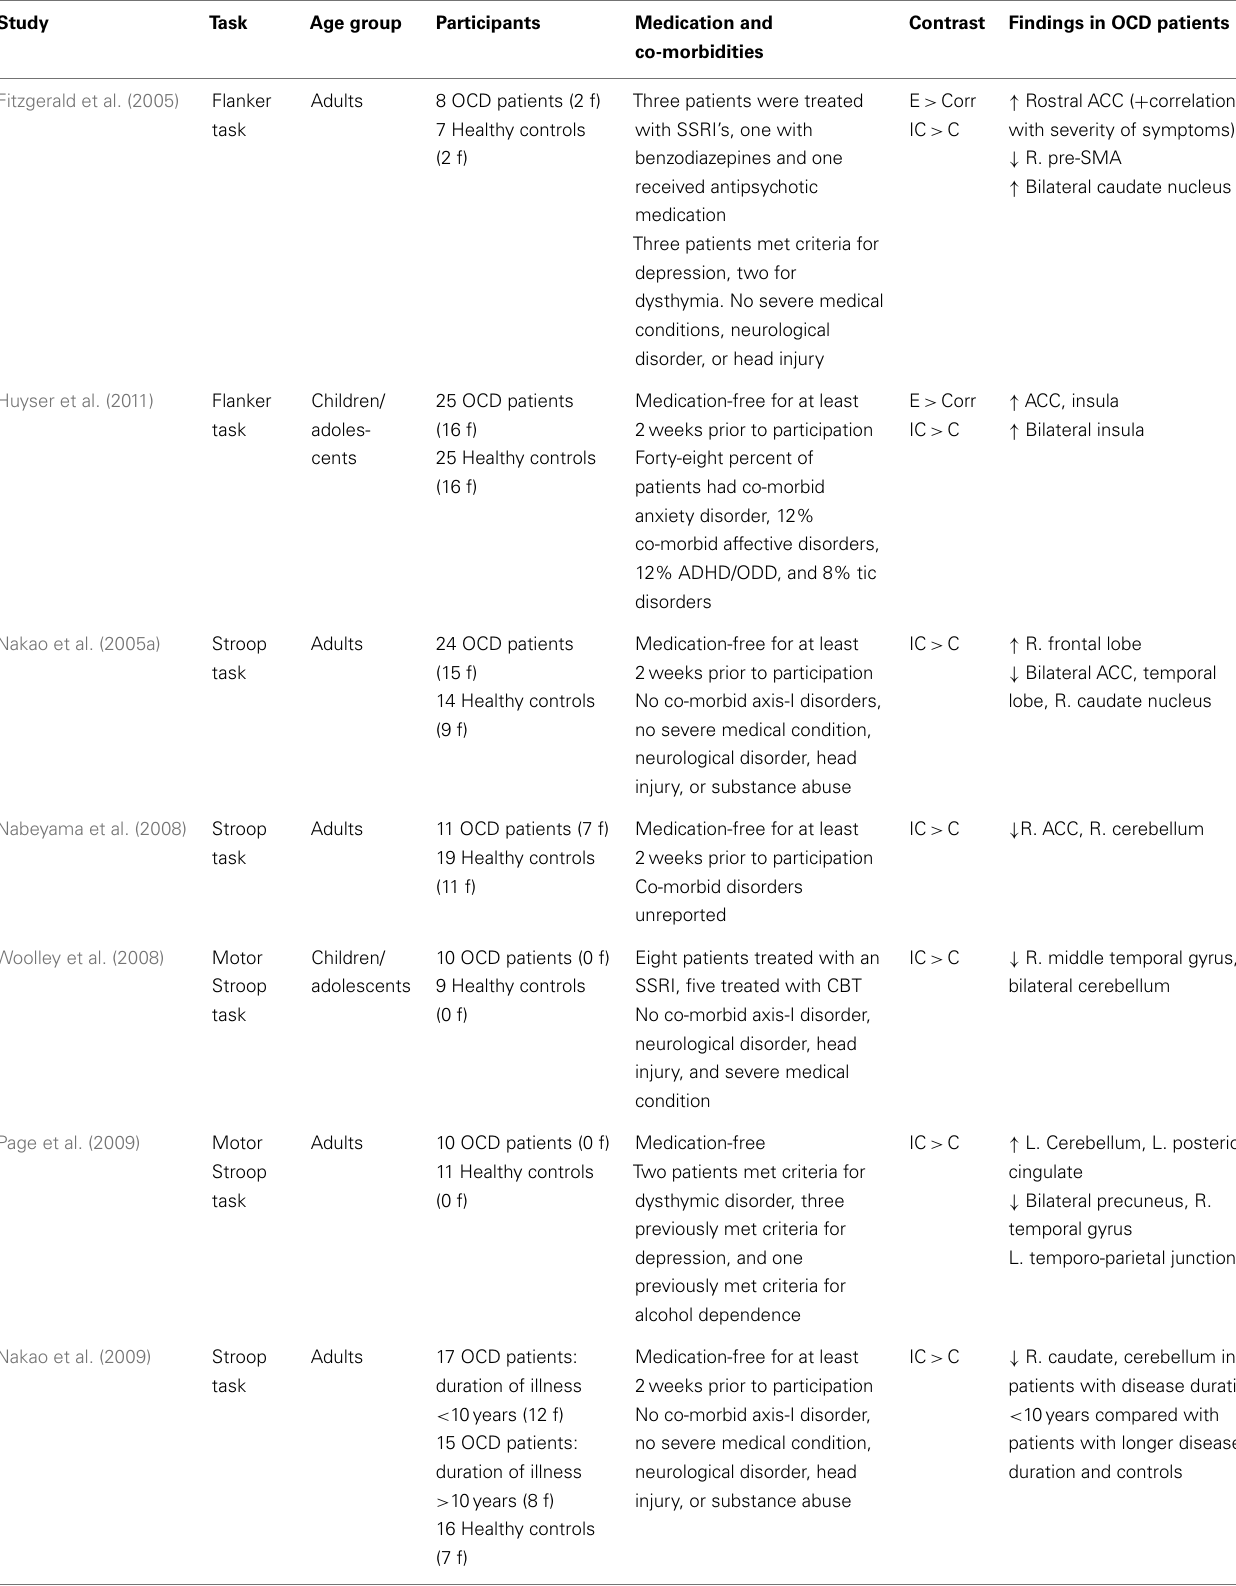
Table 1 | Overview of fMRI studies that have used interference control tasks in obsessive–compulsive disorder